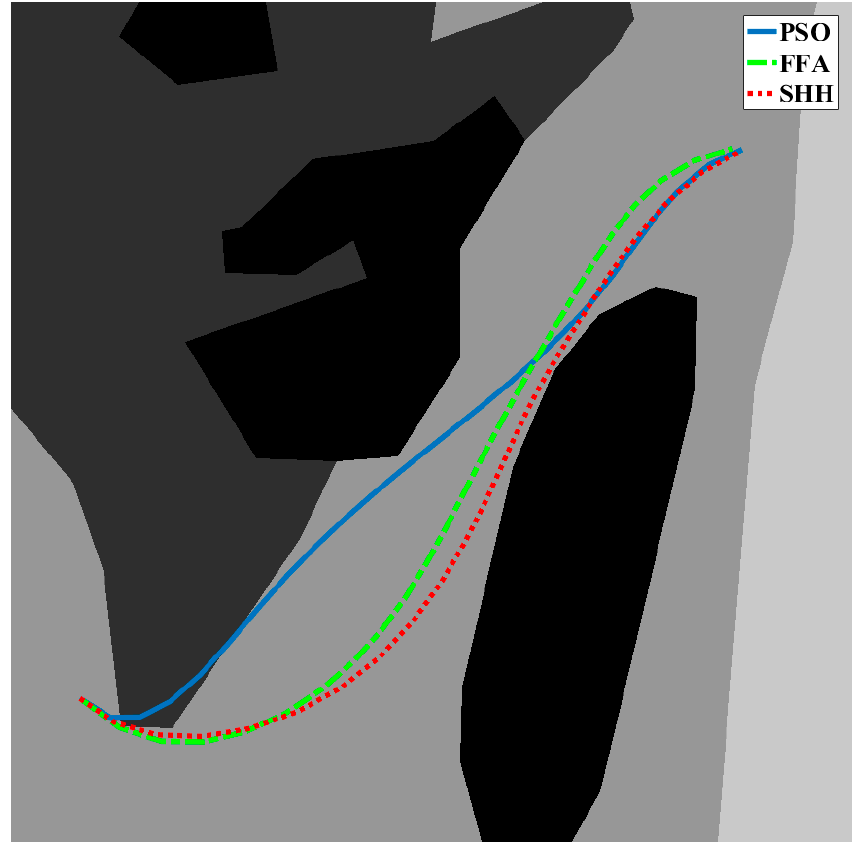
Figure 9. Comparison of the path planning results of PSO, FFA and SHH algorithms in scenario 2.